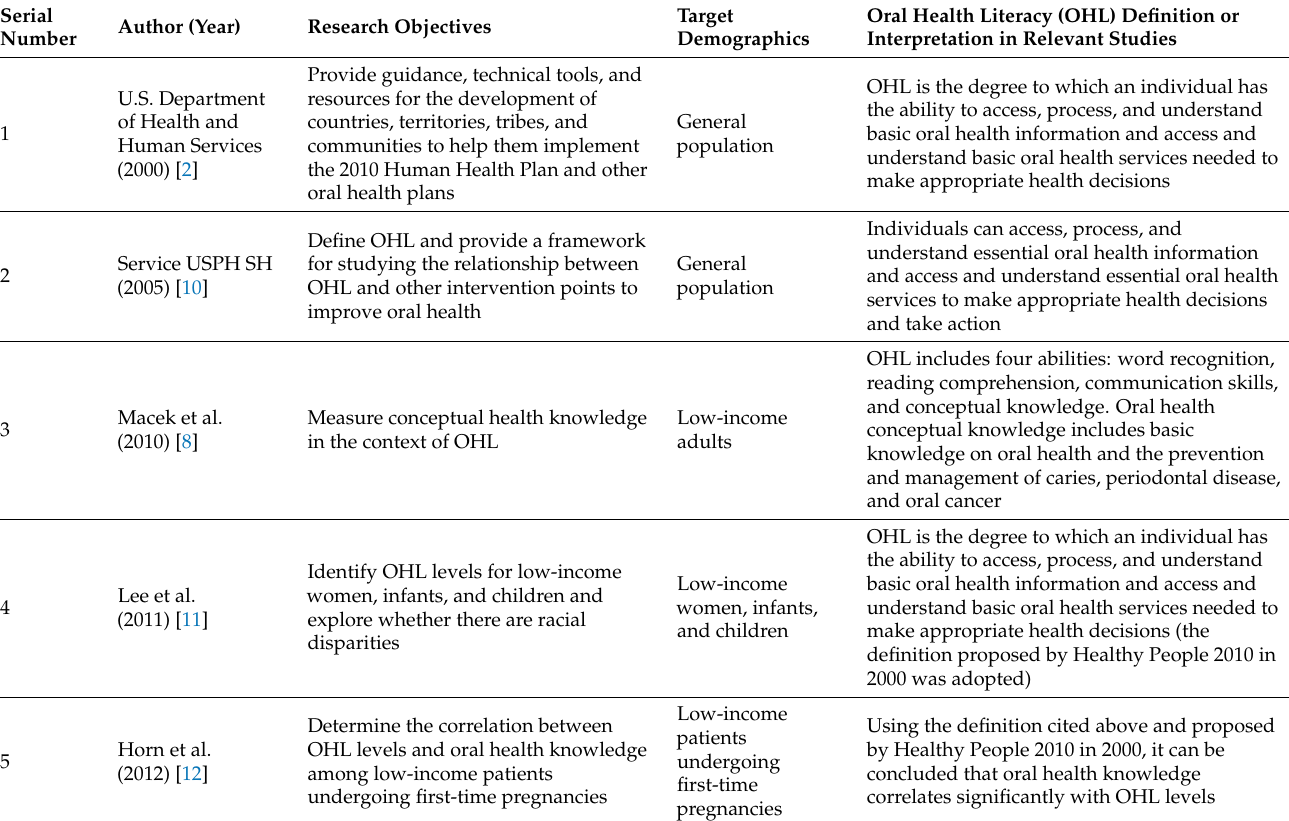
Table 1. Summary of basic information included in the OHL